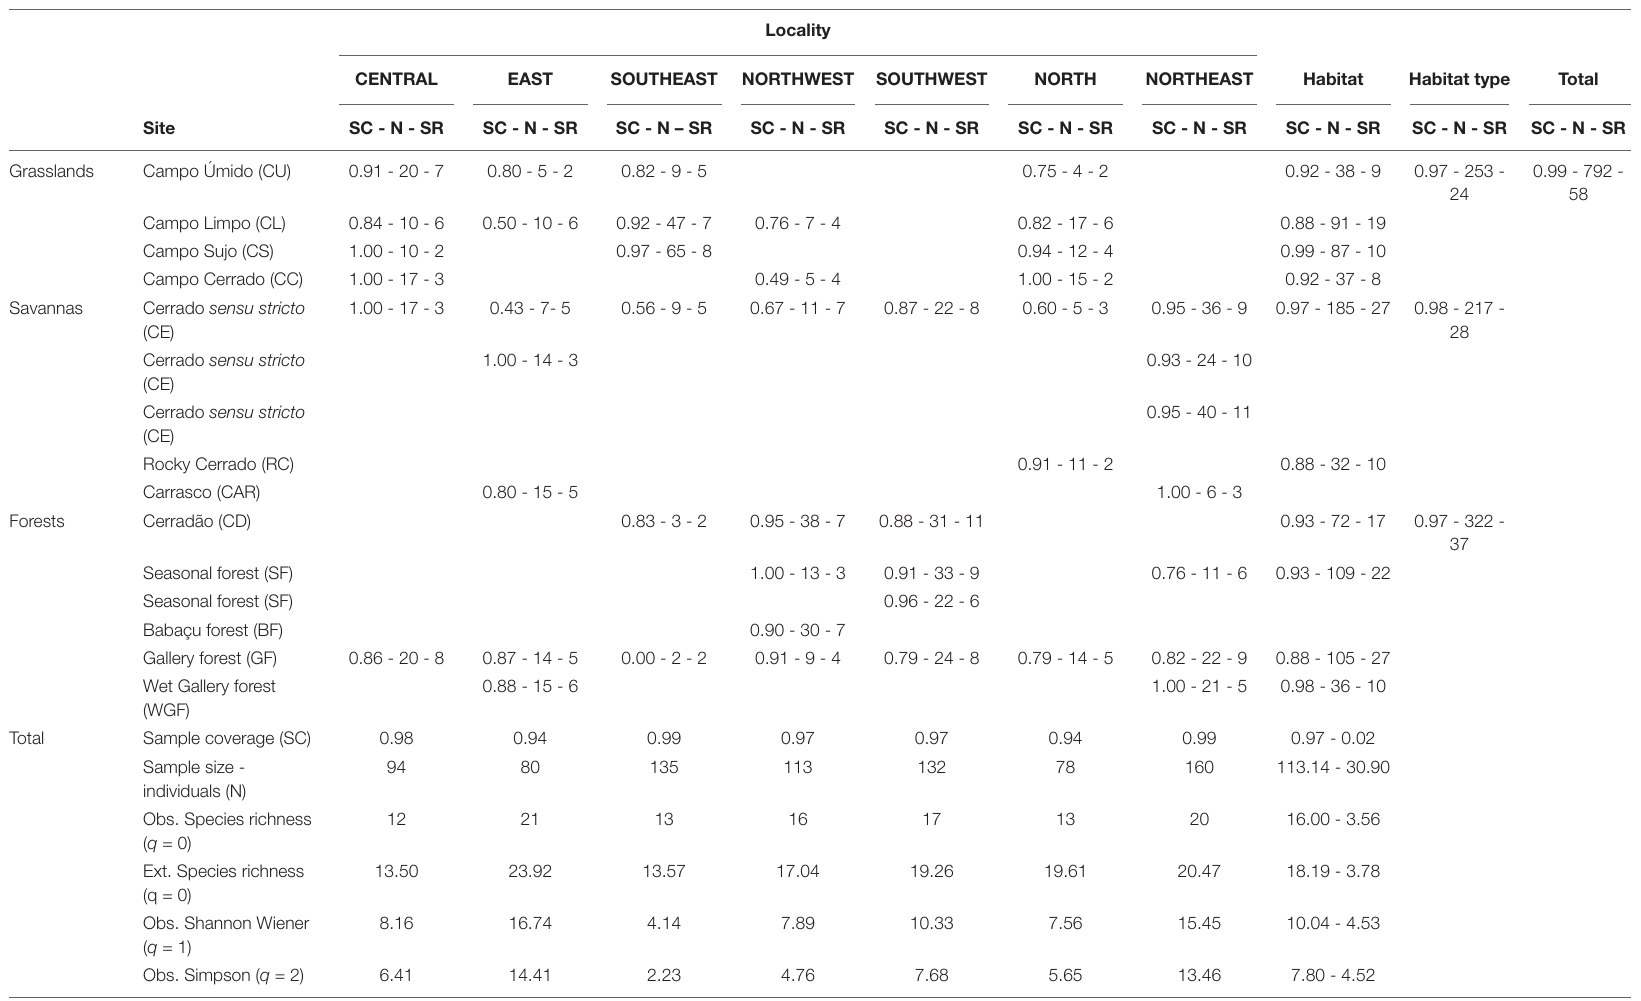
TABLE 1 | Sampling coverage (SC), sample size ( n , number of individuals), and the observed species richness (SR, q = 0), at each site, habitat, habitat type, and locality; and extrapolated SR ( q = 0), the observed Shannon index ( q = 1), and Simpson index ( q = 2) for each locality, and mean and SD for all sampled